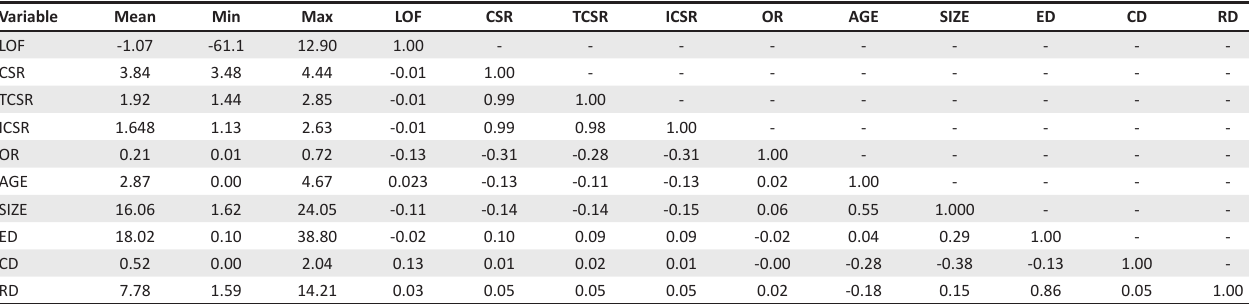
TABLE 1: Descriptive statistics and correlation analysis of variables.